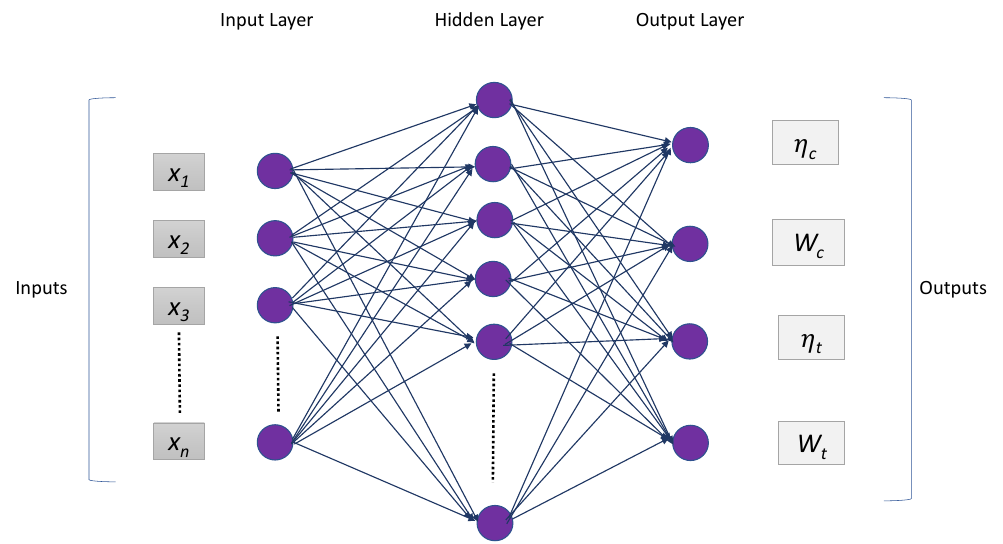
Figure 3. Structure of ANN with one hidden